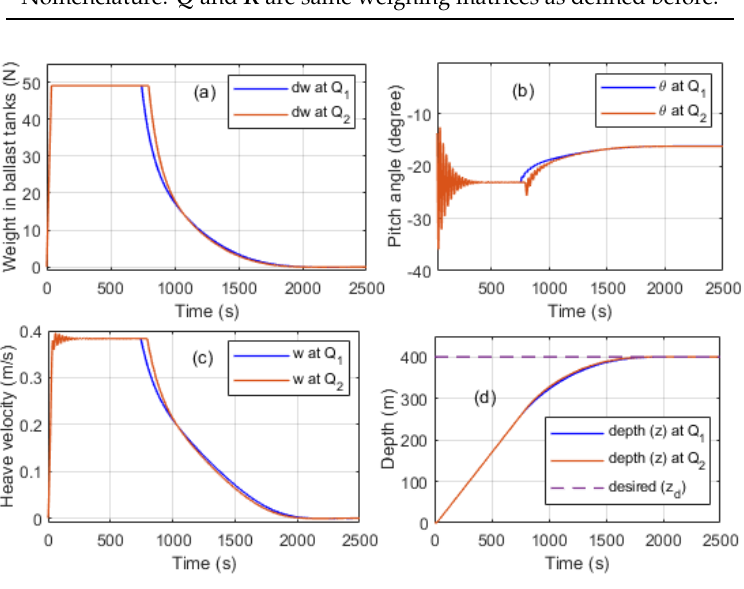
Figure 16. ( a ) Variation of the weight vs. time in ballast tanks, ( b ) pitch angle with time, ( c ) sinking (heave) velocity with time and ( d ) depth with time in closed loop for two different energy weighing matrices.